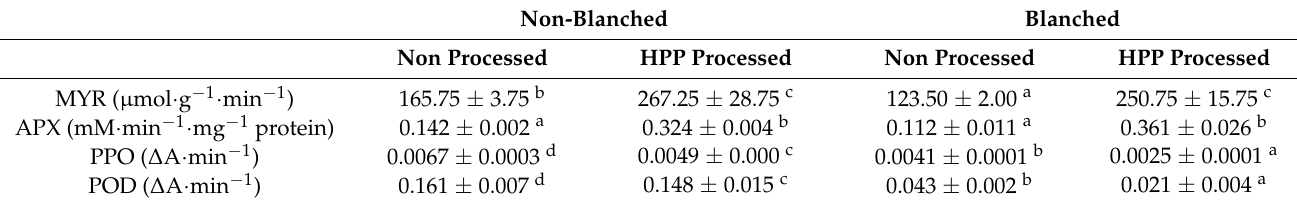
Table 1. Changes in enzyme activity in broccoli before and after high-pressure